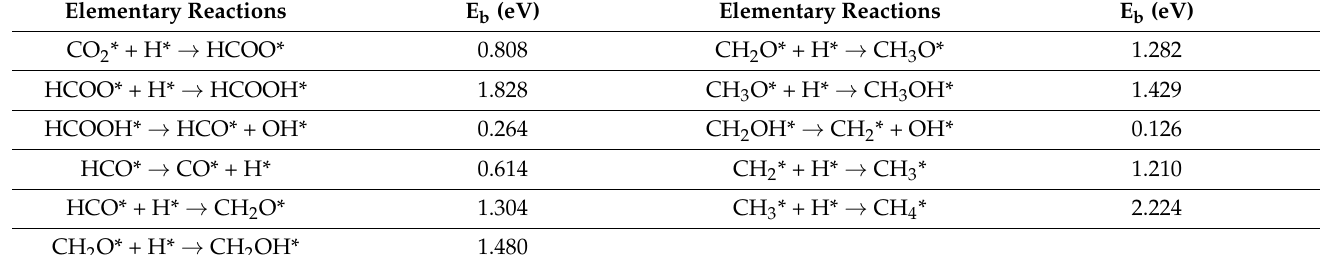
Table 3. The selected reactions and their corresponding activation barrier energies. It should be noted that the adsorbed intermediates on the surface are indicated by the symbol *.